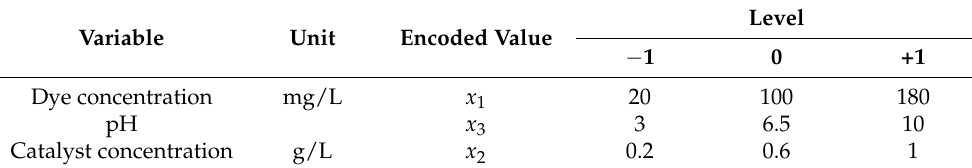
Table 7. Process parameters with experimental levels.